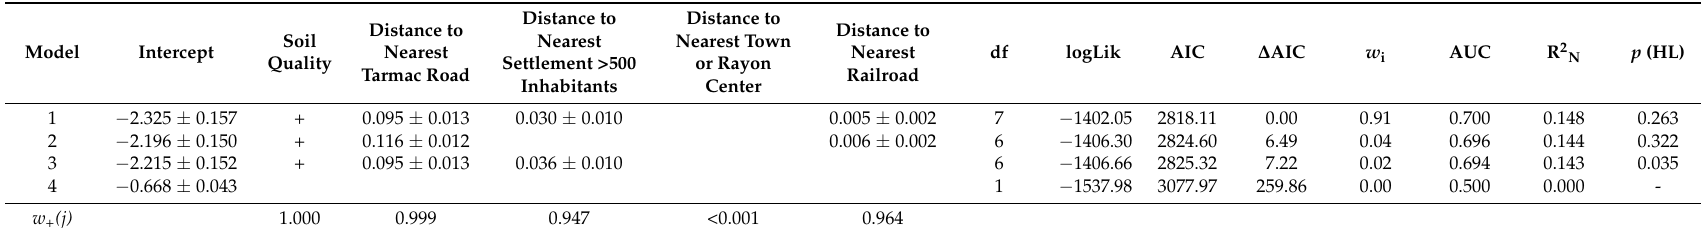
Table 5. Competing models of cropland abandonment whose Akaike weights w i sum up to 0.95, and an intercept-only model for comparison. Regression coefficients β ± 1 SE are given for all variables. A ‘+’ sign denotes a categorical variable that is included in the model. AIC—Akaike’s Information Criterion, ∆ AIC—difference in AIC to the best model, w i —Akaike weights, w + ( j )—variable importance, AUC—area under the curve of a receiver operator characteristic (ROC) plot, R 2 N